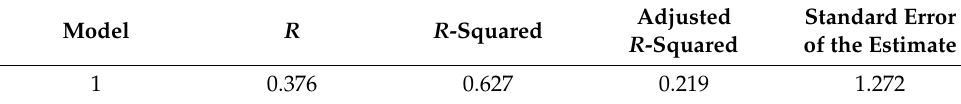
Table 5. Model summary for hypothesis H2.